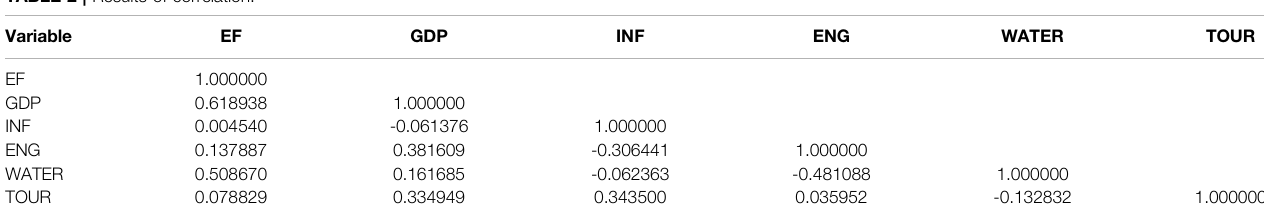
TABLE 2 | Results of correlation.